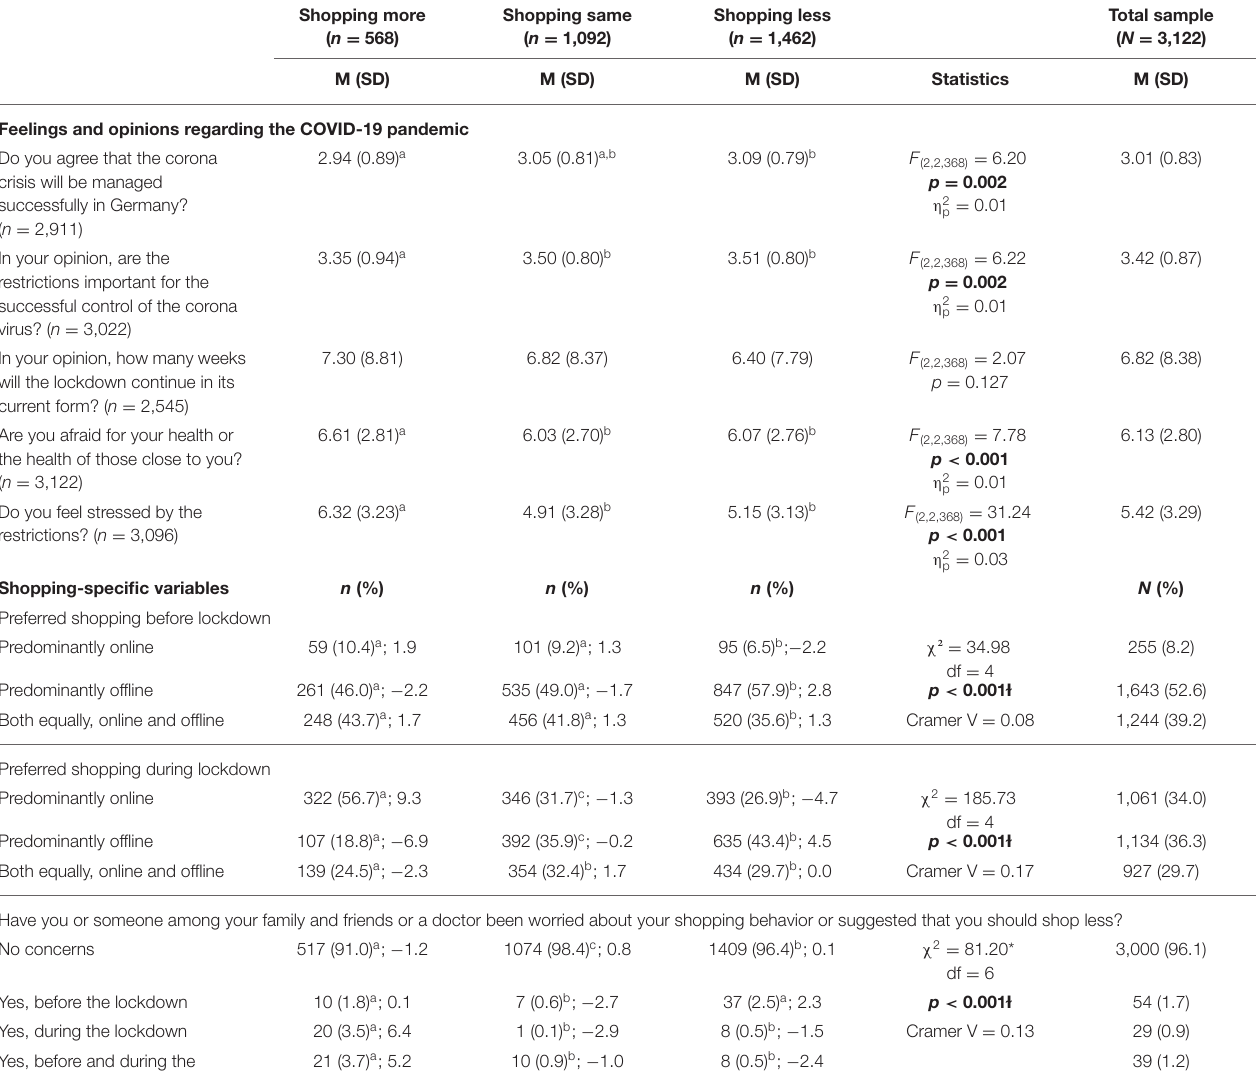
TABLE 2 | Feelings and opinions regarding the COVID-19 pandemic and shopping-specific